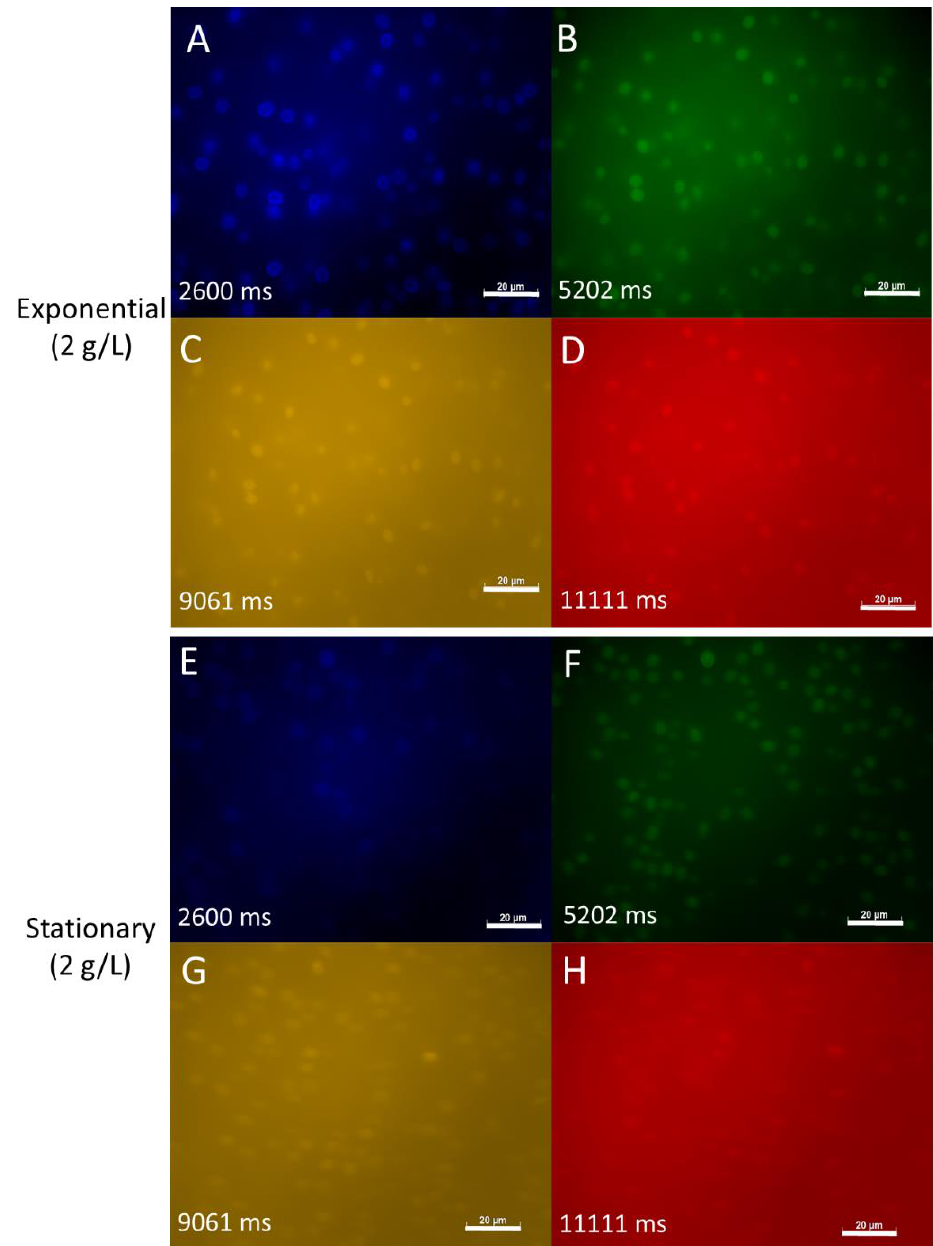
Figure 2. Autofluorescence of S. dacryoidea grown in the eutrophic medium and sampled in the exponential and stationary phase. ( A , E ): DAPI channel; ( B , F ): FITC channel; ( C , G ): DsRed channel; ( D , H ): rhodamine channel. Picture exposure times are depicted in milliseconds (ms). Scale bar = 20 µm.